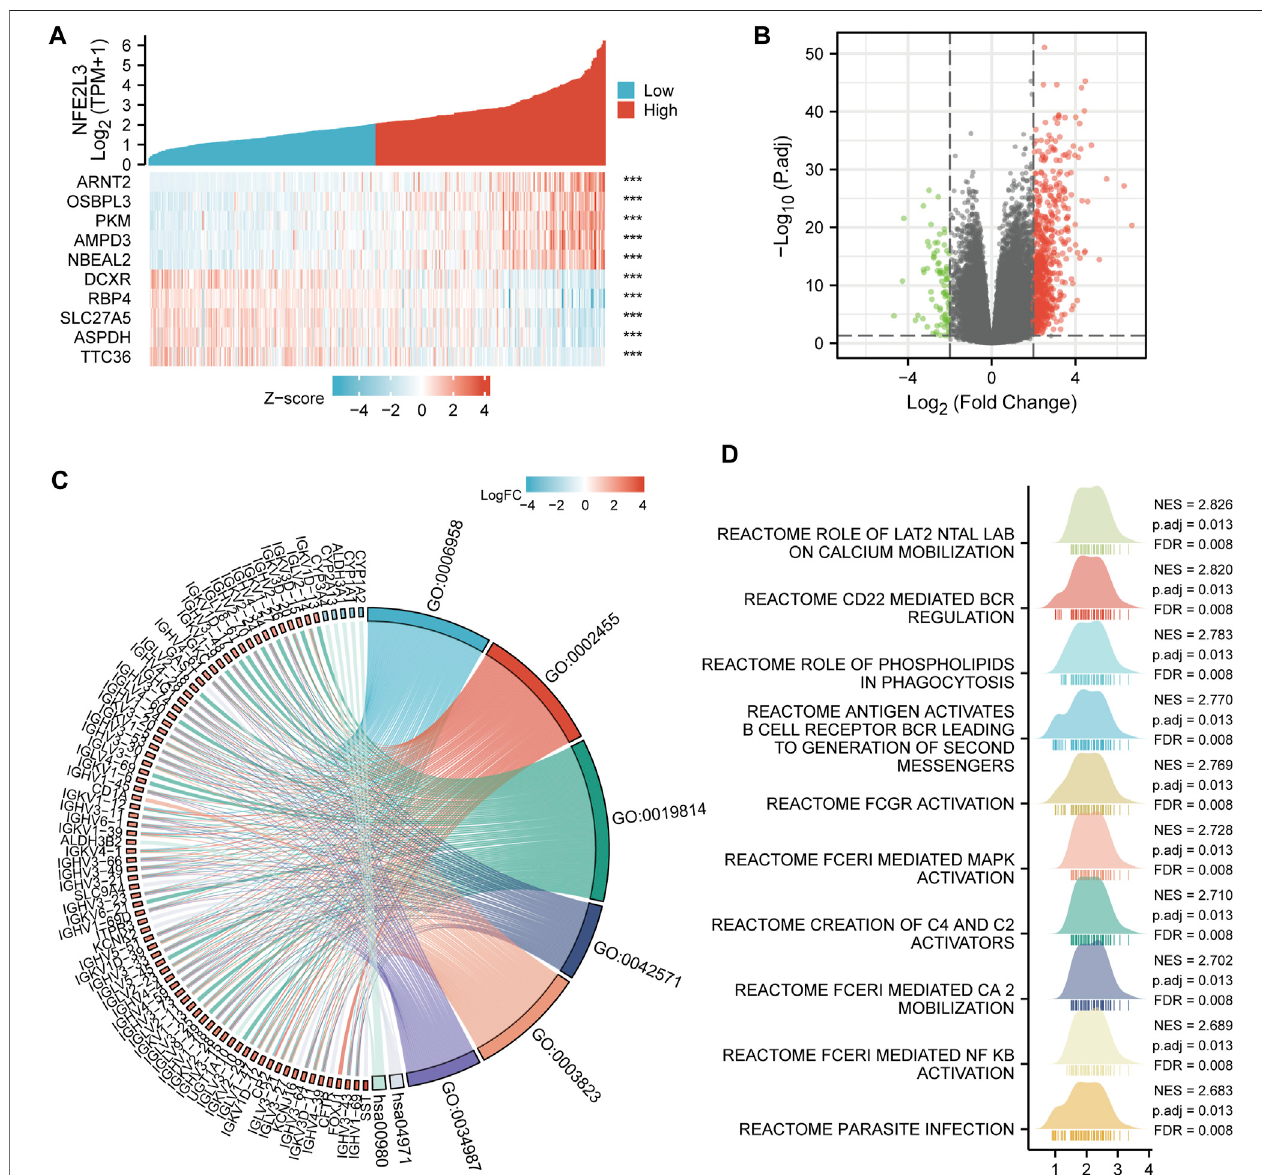
FIGURE11| Co-expressiongeneand functionalenrichmentanalysisofNFE2L3 inLIHC. (A) Thetop fi vegenes positivelycorrelatedwith NFE2L3expression,and the top fi ve genes negatively correlated with NFE2L3 expression in LIHC. (B) The volcano map of DEGs between NFE2L3 high expression group and low expression groups in LIHC. (C) GO and KEGG pathway enrichment analyses of DEGs. (D) GSEA merged plots indicated the top 10 signi fi cant signaling pathways associated with NFE2L3 expression according to Reactome analyses in